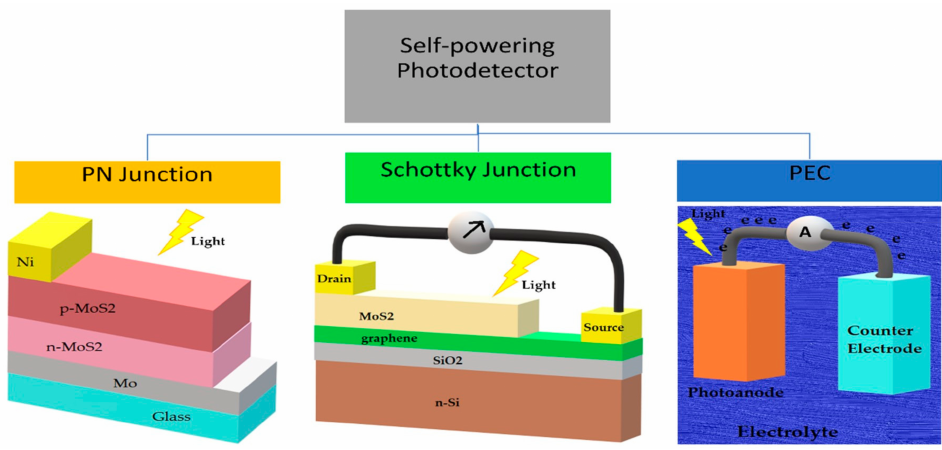
Figure 1. Types of self-powered